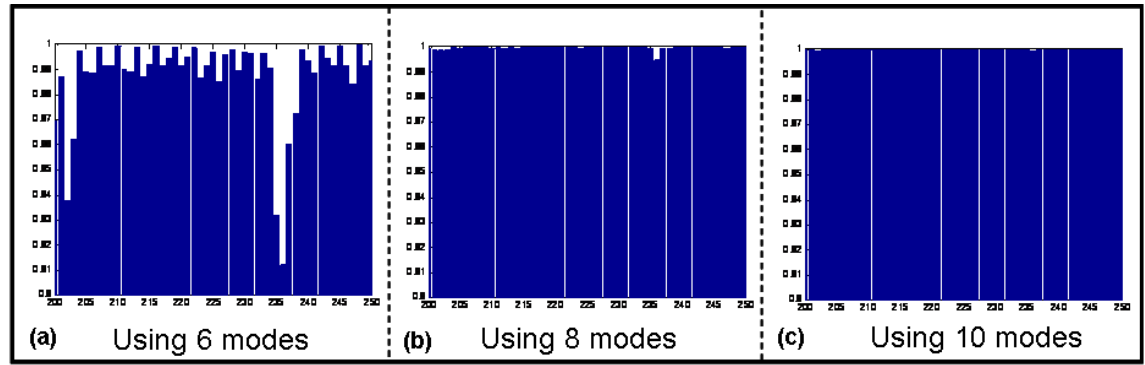
Fig. 7. MAC between displacement response vectors of reference and expansion algorithm solutions with different number of modes used for expansion, (a) using first 6 modes (b) using first 8 modes, (c) using first 10 modes in expansion process; MAC performed for time steps 200−250 and shown for